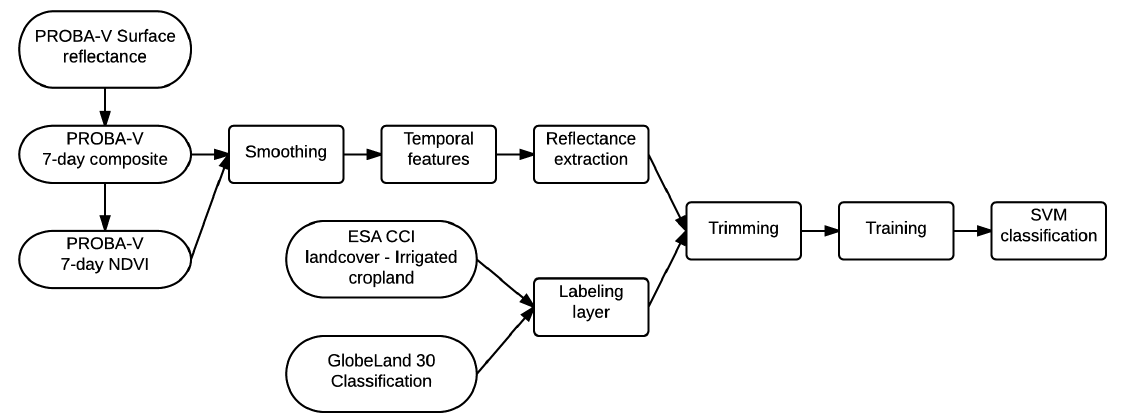
Figure 6. Three-step methodology for cropland classification: (i) extraction of the temporal features; (ii) local training based on trimmed data; (iii) classification using